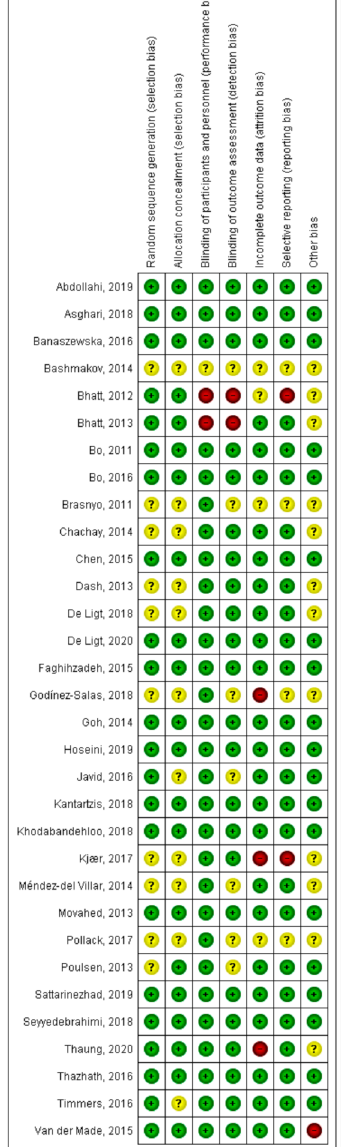
Figure 2. Assessment of the risk of bias and methodological quality of clinical trials included. Most clinical trials display a low risk of